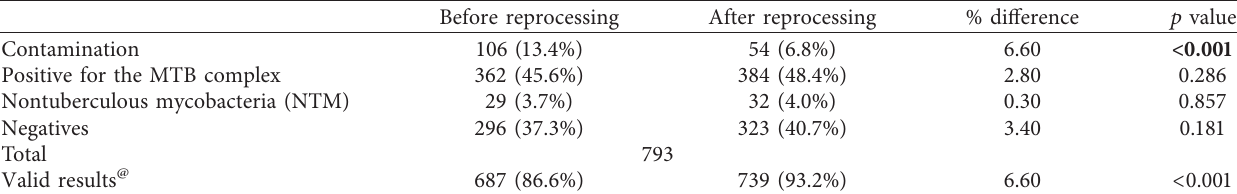
Table 1: Effect of reprocessing of the contaminated mycobacterial liquid culture. Before